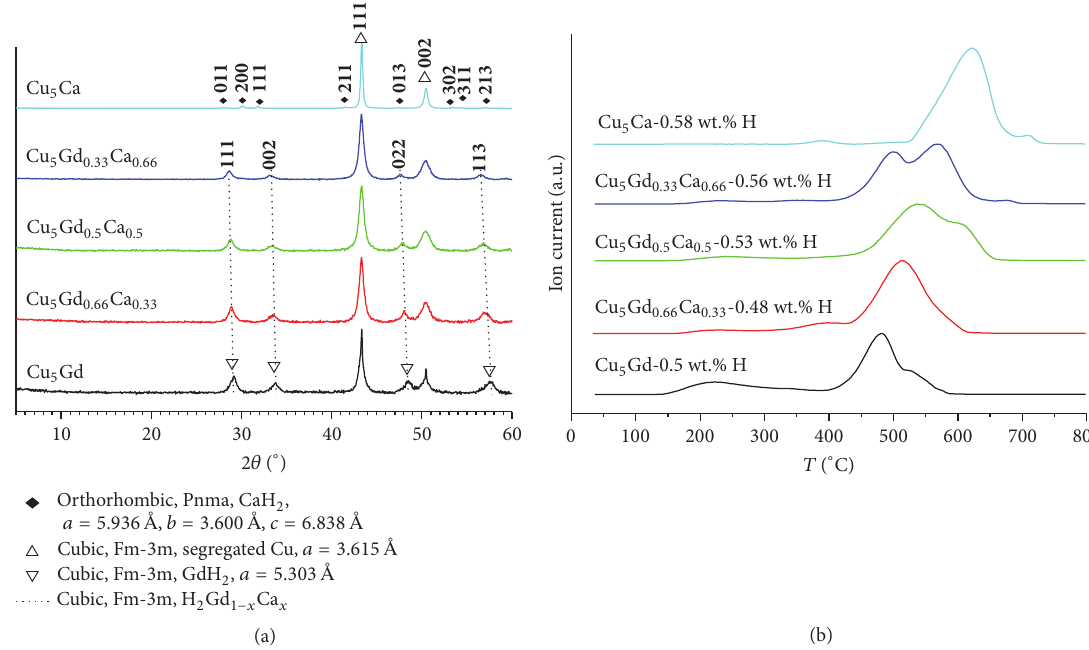
Figure 8: (a) XRD patterns of hydrogenated Cu 5 Gd 1−𝑥 Ca 𝑥 ( 𝑥 = 0, 0.33, 0.5, 0.66, and 1) melt-spun ribbons and (b) corresponding mass- spectra of thermally desorbed hydrogen